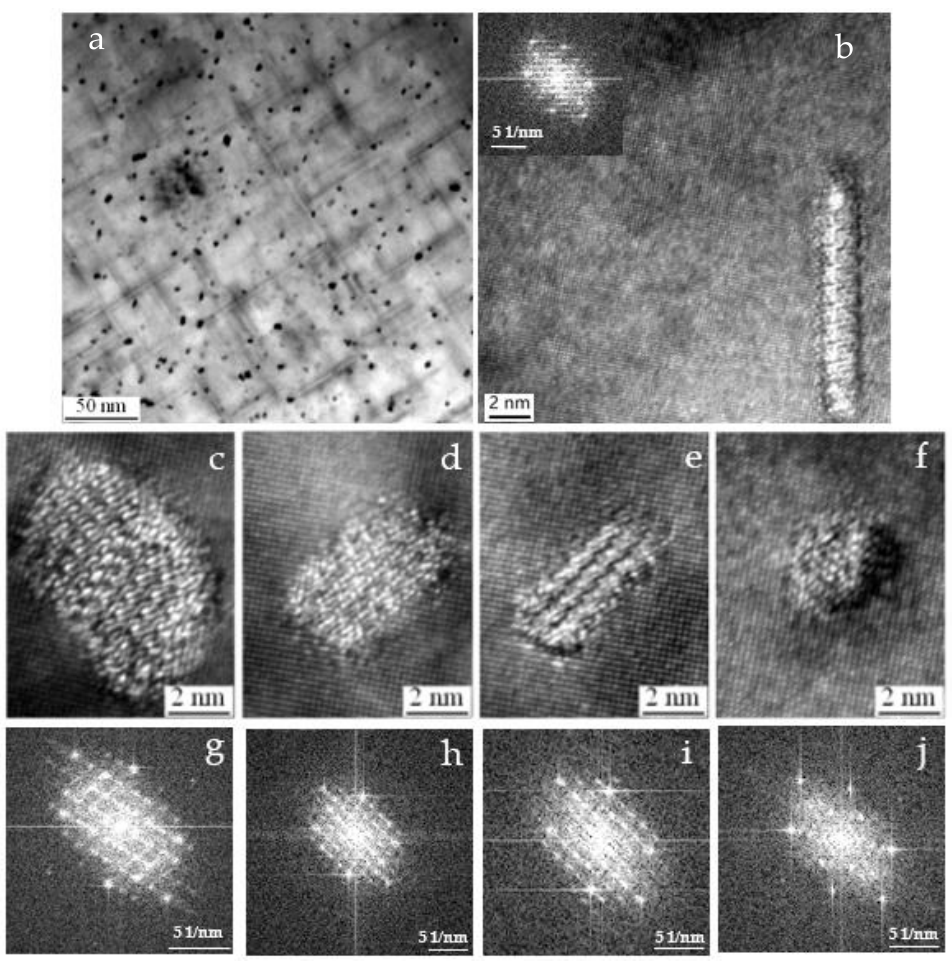
Figure 5. ( a ) Bright-field TEM images of the as-solutionized alloy aged at 180 °C for 4 h with zone axis [001] Al , ( b – f ) the HRTEM images of a cross-section of precipitates, ( g – j ) the Fourier transform of the HRTEM images in ( c – f ), respectively.